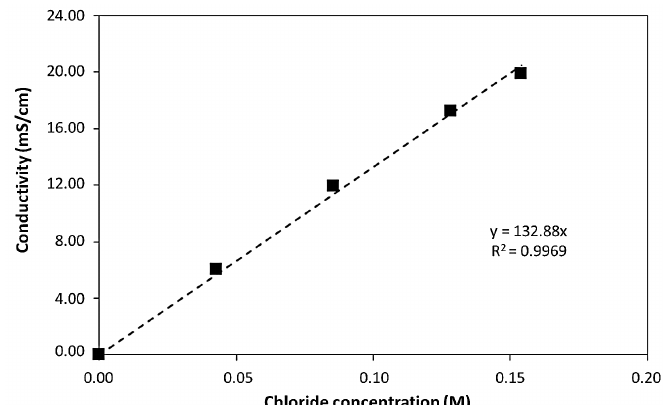
Figure 2. Experimental relationship between electrical conductivity and chloride concentration in the anodic compartment, which initially contains distilled water.